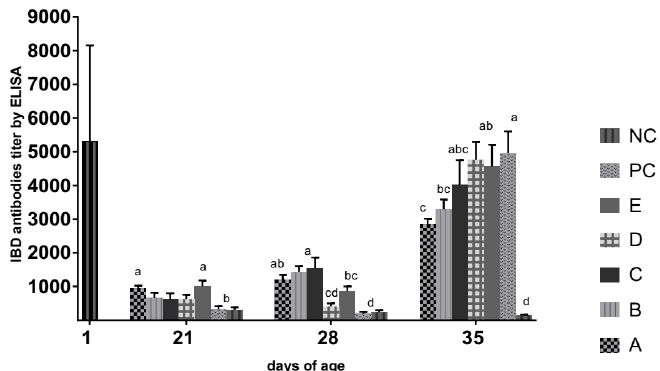
Figure 2. IBDv antibody titers with standard deviation in commercial broilers vaccinated with different IBD vaccines. (A): Vaccinated with HVT-IBD vector vaccine at hatchery. (B): Vaccinated with